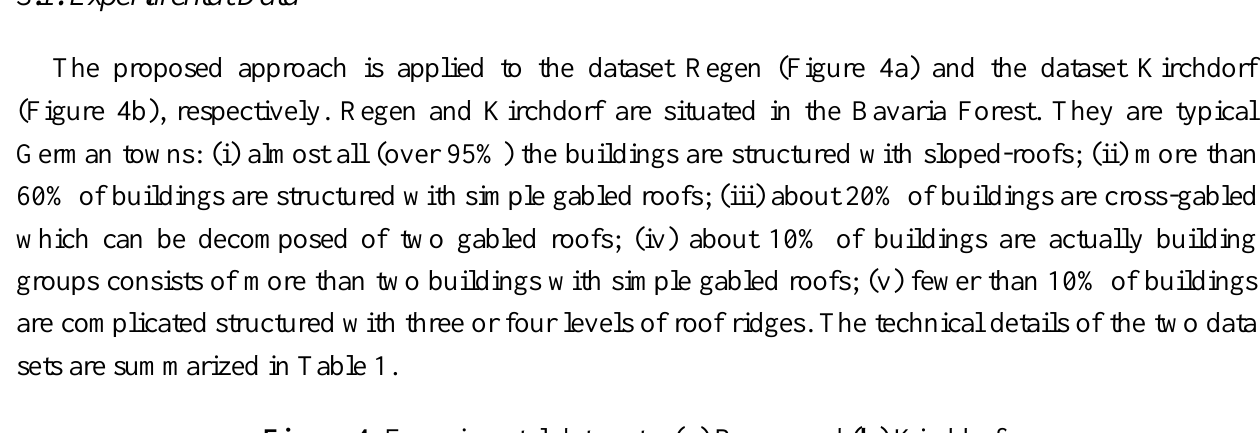
Figure 4. Experimental data sets: ( a ) Regen and ( b ) Kirchhof.